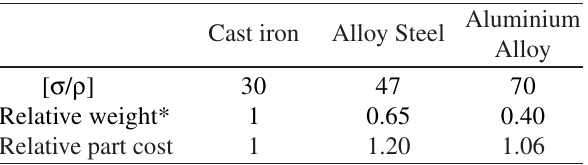
Table 3. Relevant properties of the component constructed with the candidate materials